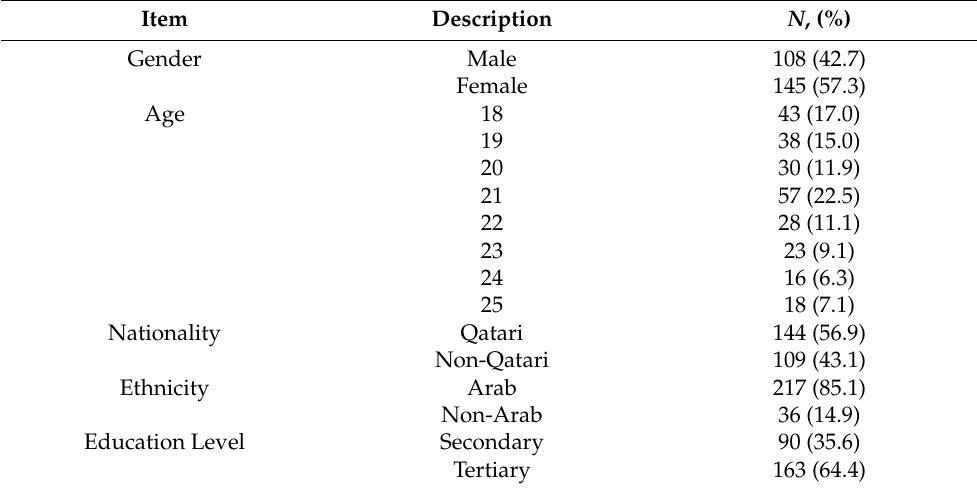
Table 1. Young drivers’ background characteristics (N total =